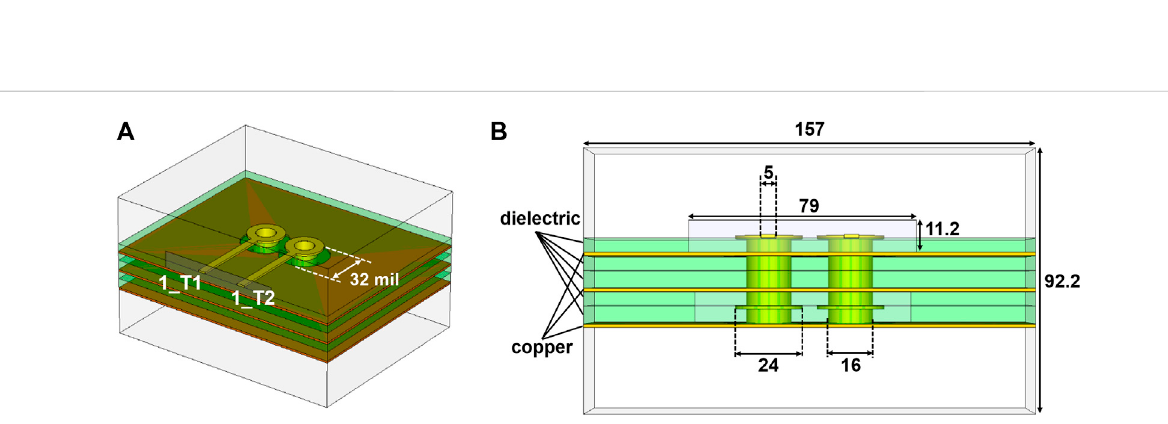
FIGURE 11 (A) Geometry and (B) front view of the via model.